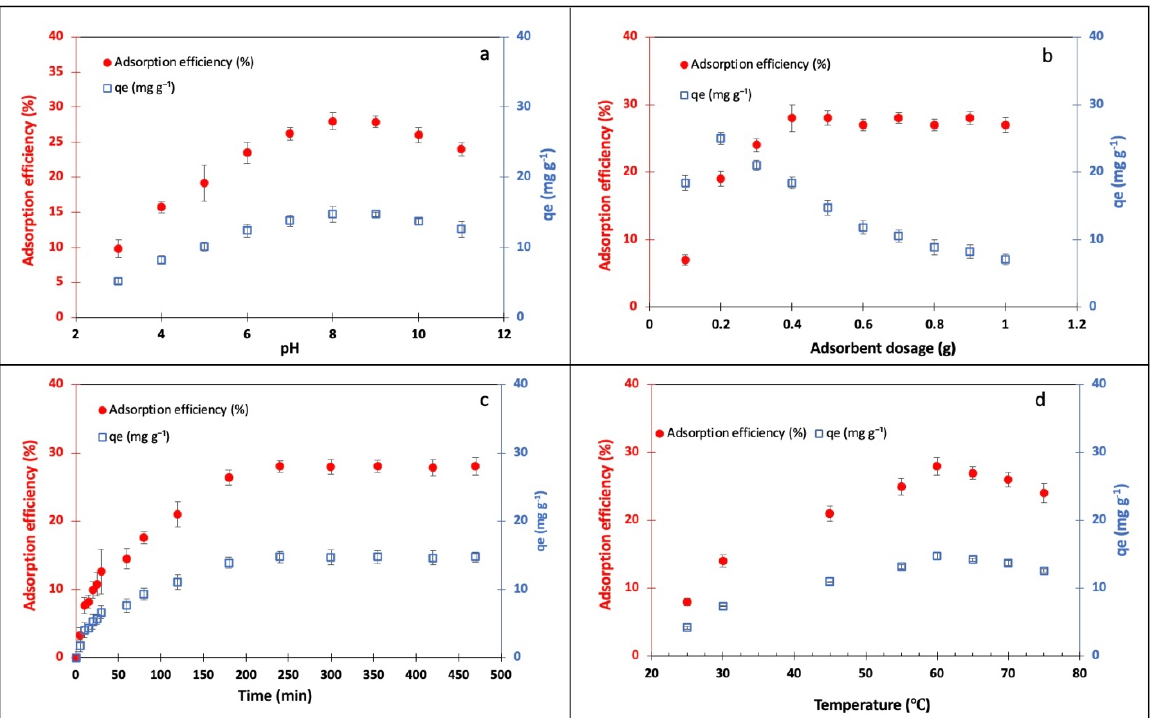
Figure 4. ( a ) Effect of pH (conditions: 20 mL of 1315 mg L − 1 mucosa sample, 0.5 g of QDASi, temperature 55 ◦ C, and 240 min of contact time); ( b ) adsorbent dosage (conditions: 25 mL of 1315 mg L − 1 mucosa sample at pH = 8, temperature 55 ◦ C, and 240 min of contact time); ( c ) contact time (conditions: 25 mL of 1315 mg L − 1 real sample at pH = 8, 0.5 g of QDASi, and temperature 55 ◦ C); and ( d ) temperature (conditions: 25 mL of 1315 mg L − 1 real sample at pH = 8, 0.5 g of QDASi, and 300 min of contact time) of the adsorption efficiency of heparin over